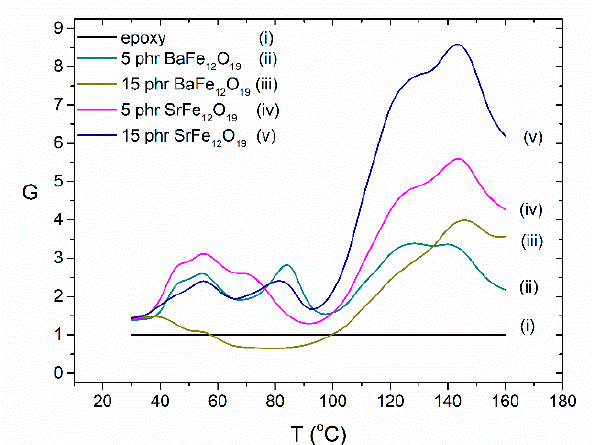
Figure 7. Dielectric Reinforcing Function (DRF) as a function of temperature at 0.1 Hz, for the nanocomposites with 5 phr and 15 phr BaFe 12 O 19 and SrFe 12 O 19 content.